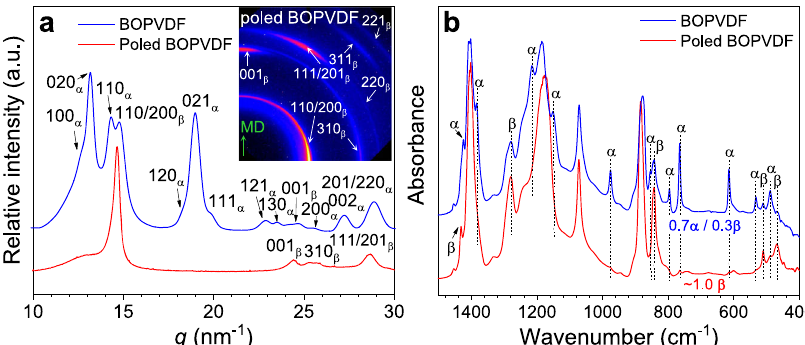
Fig. 1 Structural characterization by WAXD and FTIR. a 1D WAXD pro fi les for the fresh and poled BOPVDF fi lms at room temperature. The inset shows the 2D WAXD pattern (in a logarithmic scale) for the poled BOPVDF fi lm. The X-ray beam is along the transverse direction (TD) and the machine direction (MD) is vertical. b FTIR spectra for the fresh and poled BOPVDF fi lms in the transmission mode. Absorption bands for α and β crystals are